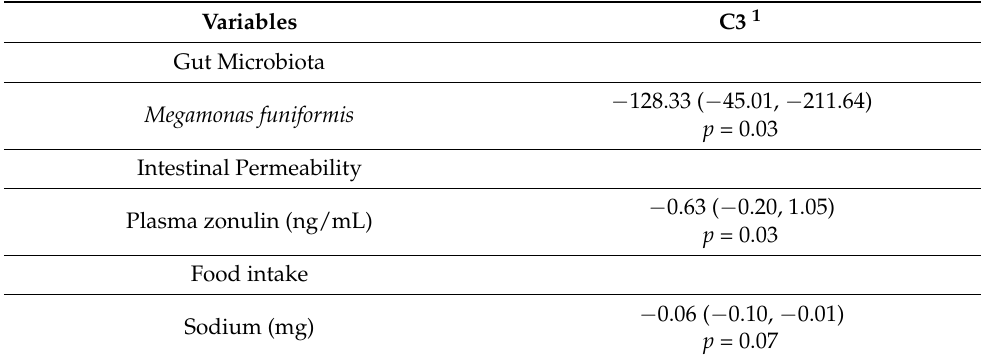
Table 4. Multiple regression model with the effect of gut microbiota, intestinal permeability, and food intake (independent variables) on C3 complement (dependent